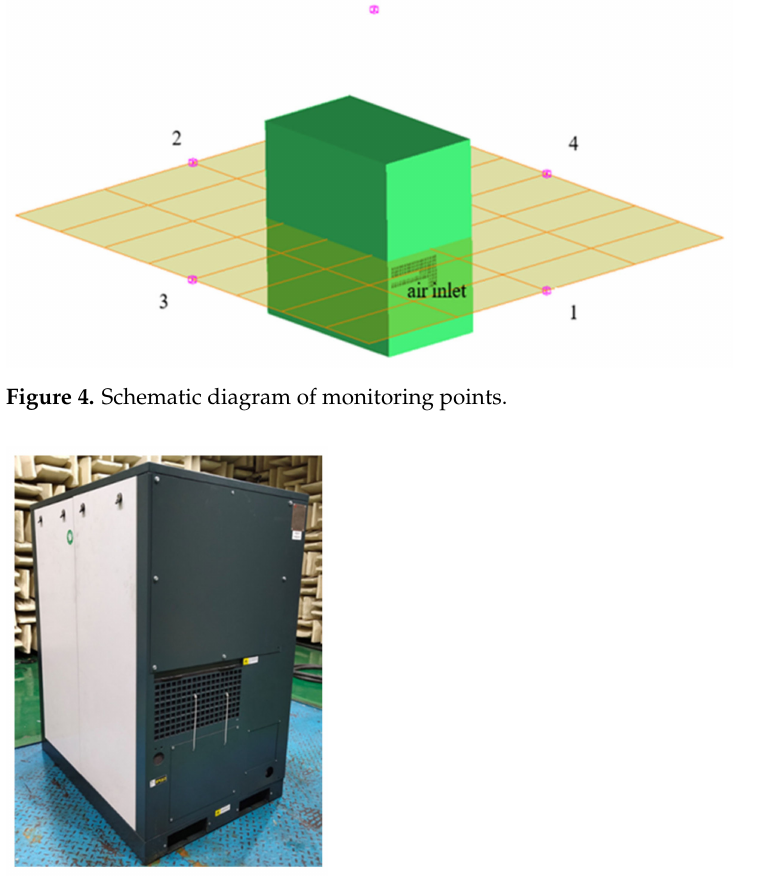
Figure 5. The structure of the sound insulation hood of the air